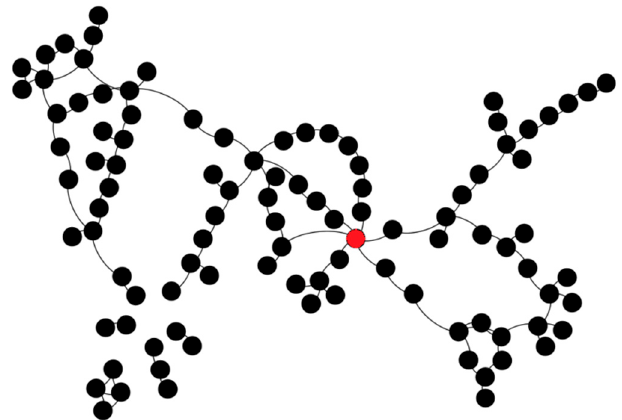
Figure 8. The state of the graph after removing the vertex of the ninth degree with the selected next-removed vertex of BGC, which has k = 6.